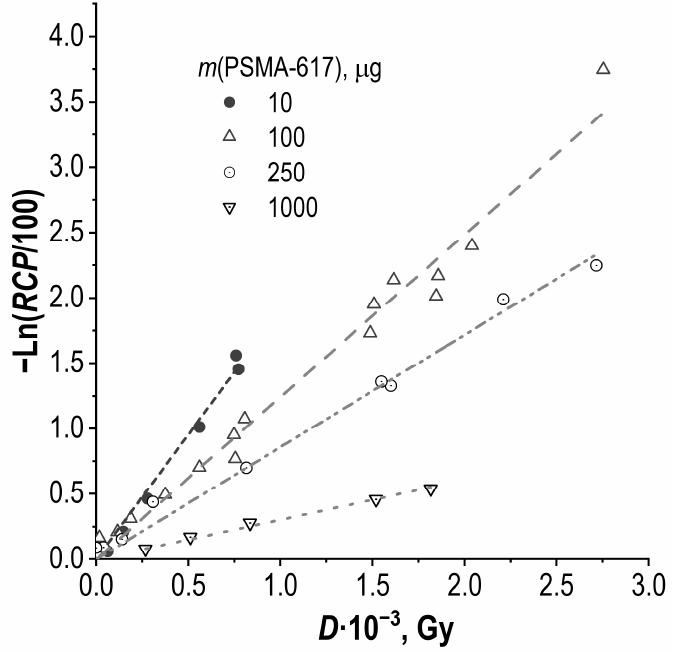
Figure 16. Influence of PSMA-617 precursor amount in the sample on the degree of radiolitic degradation of [ 177 Lu]Lu-PSMA-617 during storage (samples volume—1 mL, 177 Lu activity in the sample—450–4500 MBq, pH 4.5, C(Na-acetate) = 0.03 mol/L; error bars are omitted for clarity). Here, ( κ ± SD ) · 10 3 is: 1.911 ± 0.061 for 10 µ g/mL ( R 2 0.9950); 1.241 ± 0.027 for 100 µ g/mL ( R 2 0.9924); 0.859 ± 0.020 for 250 µ g/mL ( R 2 0.9952), and 0.3033 ± 0.0062 for 1000 µ g/mL ( R 2 0.9983).